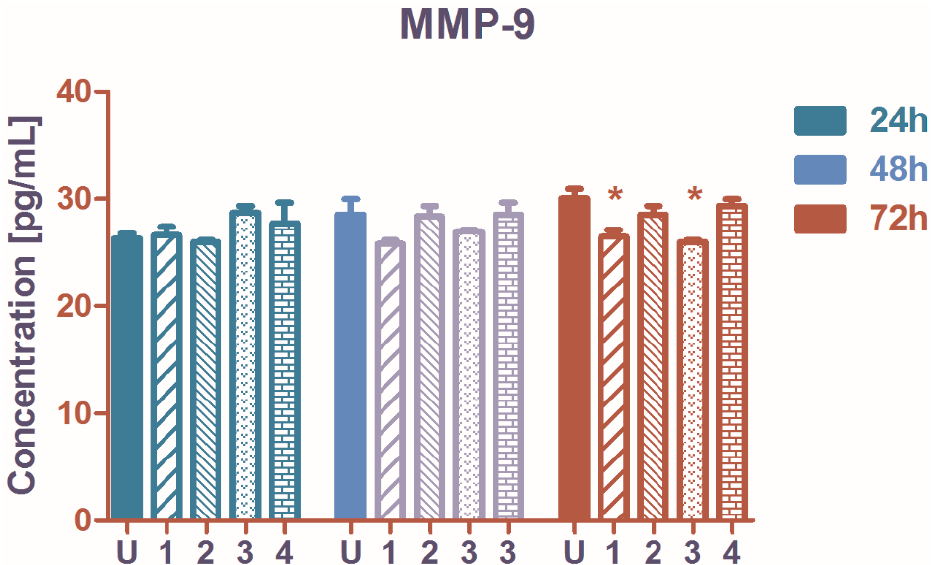
Figure 5. The concentration (pg/mL) of secreted matrix metalloproteinase-9 (MMP-9) in the extra- cellular medium of A2780 cells treated with ruthenium complexes 1 – 4 in vitro. U represents the untreated cells, 1 , 2 , 3 and 4 the ruthenium complexes; 24-, 48- and 72 h are the exposure times. Starred columns represent the significant changes versus the untreated cells. Starred columns represent the significant changes versus the untreated control.